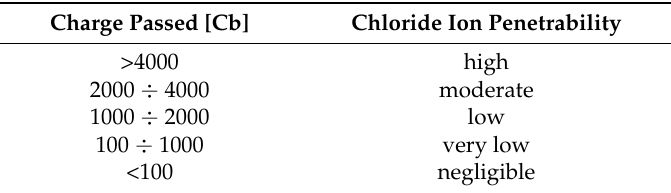
Table 1. Chloride ion penetrability based on charge passed.